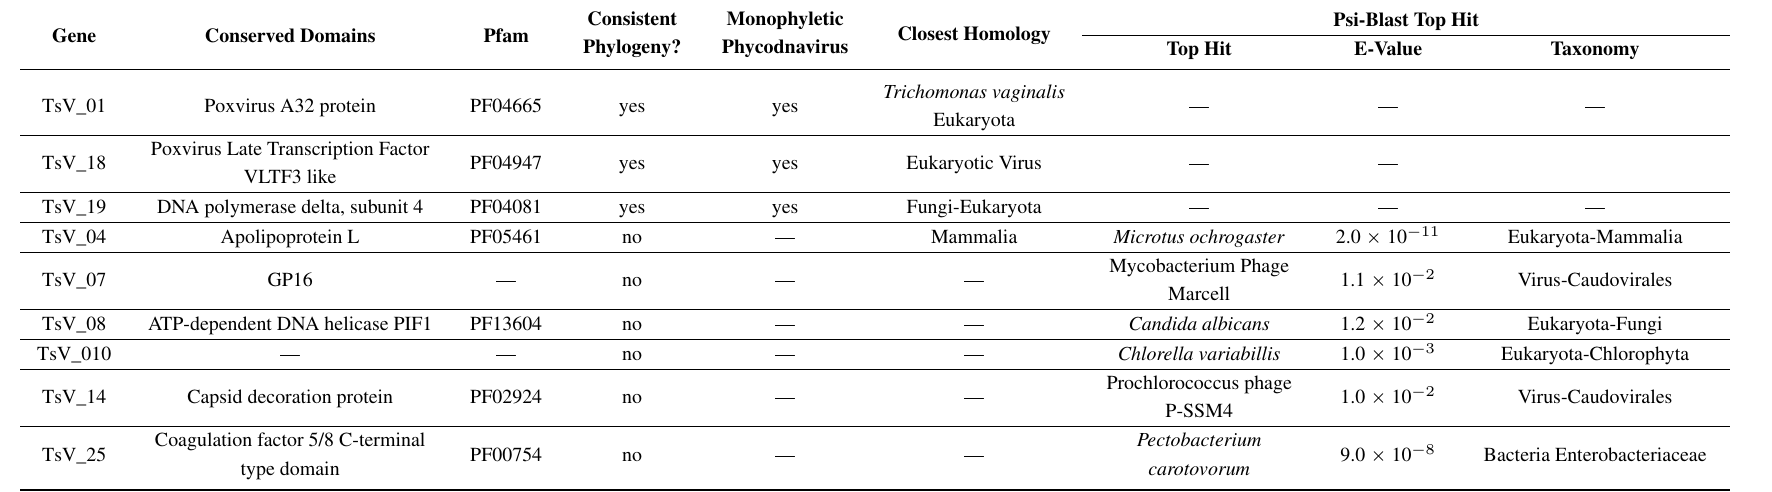
Table 2. Putative annotation as well as phylogenetic homology recovered for TsV-N1